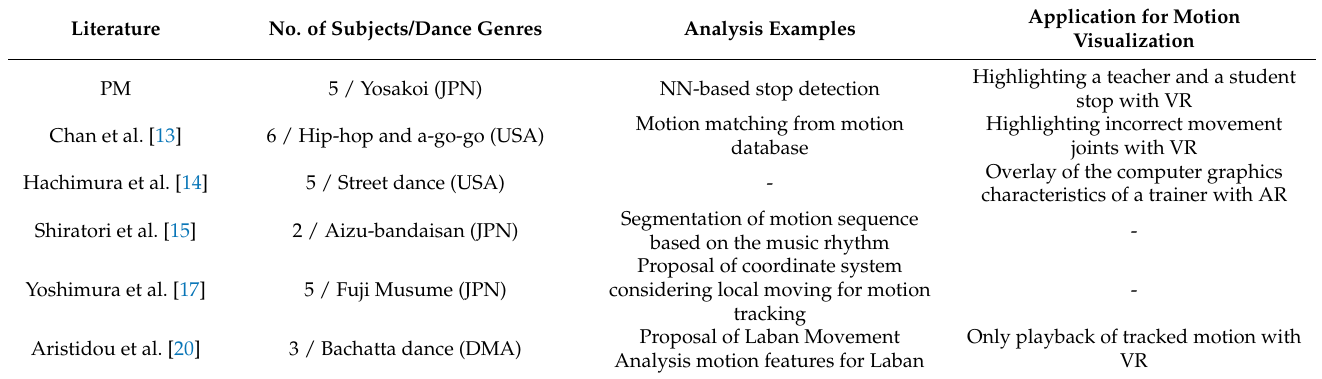
Table 8. List of analyses and visualization features in related